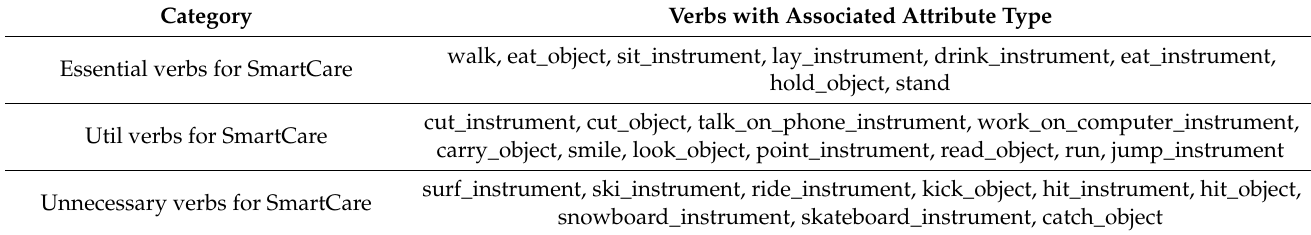
Table 6. V-COCO categories in SmartCare.